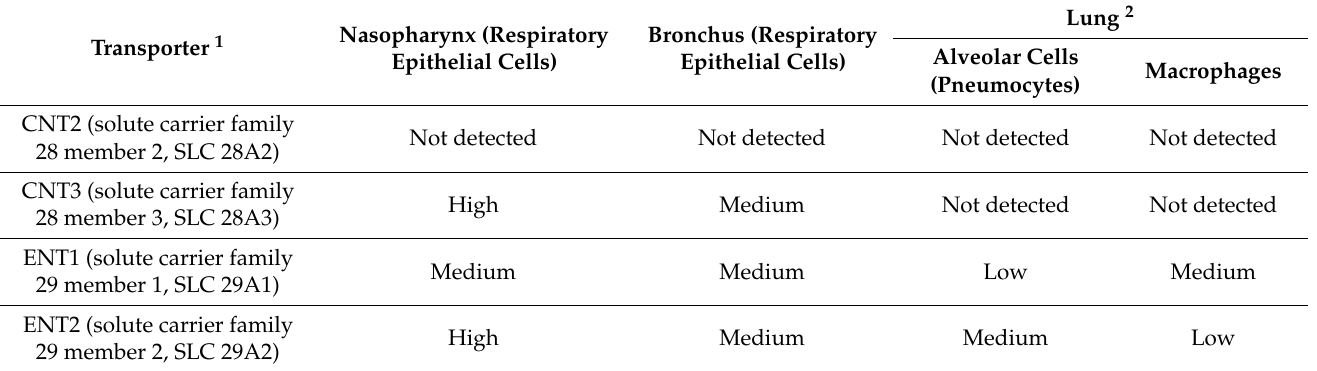
Table 3. Expression of nucleoside transporters potentially implicated in the uptake of GS-441524 in the human respira- tory